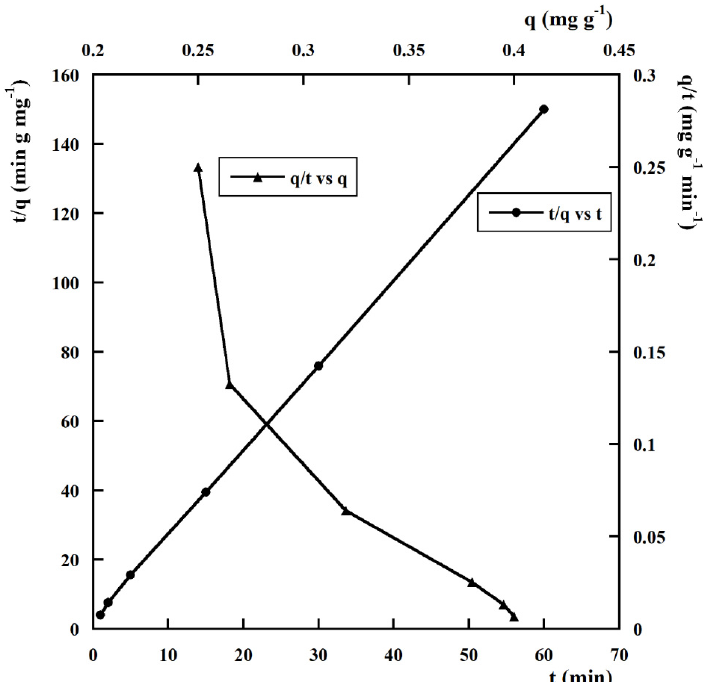
Figure 5. Comparison between the plots of q vs. t and q/t vs. q for the sorption of Cr(VI) onto MnO 2